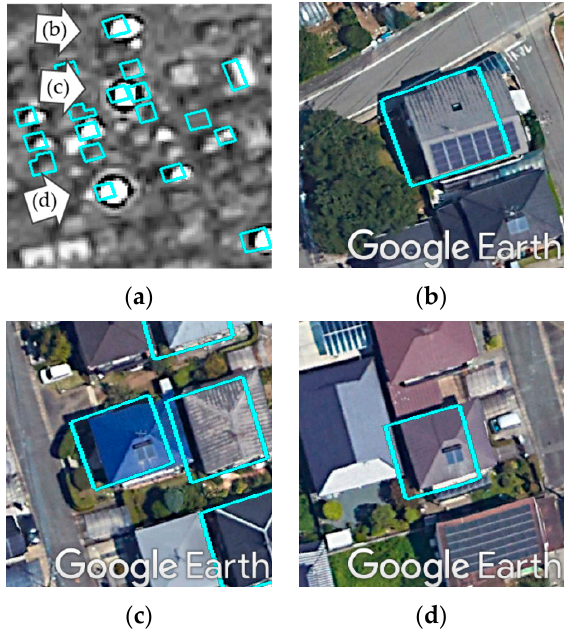
Figure 19. Examples of positions and reflecting objects causing anomalous bright pixels: ( a ) 25 March 2016 SPOT image and arrows showing position for ( b) , (c), and( d ) of Google Earth imageries [30]; ( b ) solar cell panels; ( c ) solar heating water tank; and ( d ) solar heating water tank.